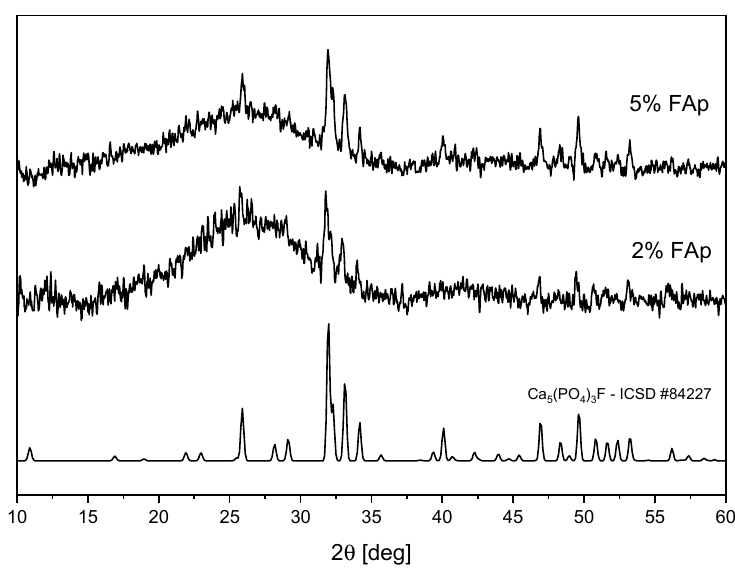
Figure 1. XRD diagrams of polymers with different contents of FAp.